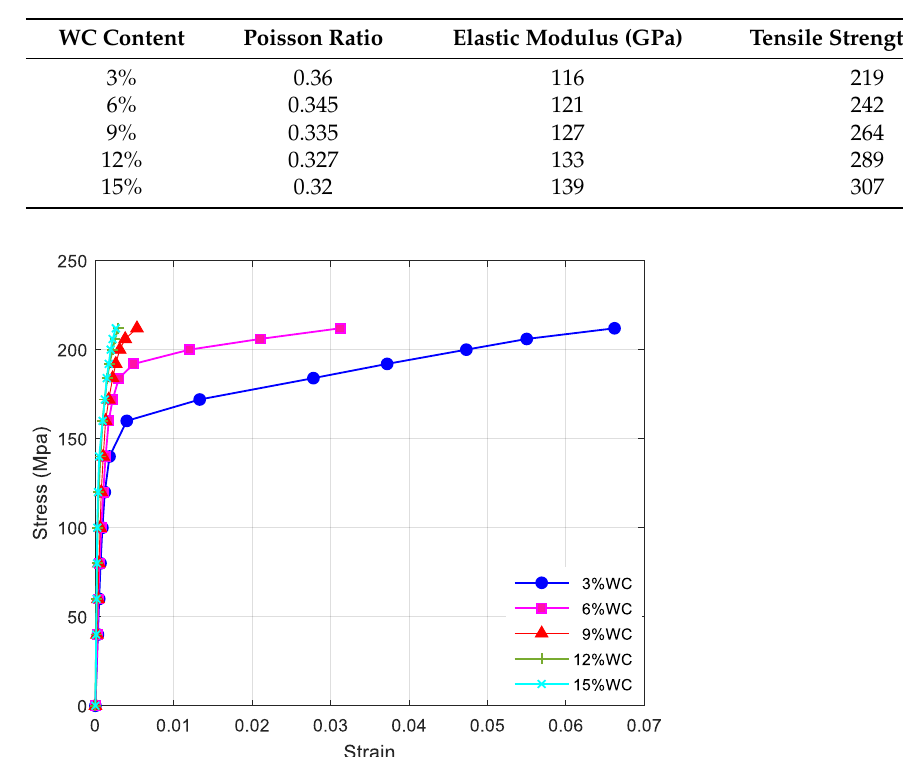
Table 1. Mechanical properties of Cu/WC P composites with different volume content.